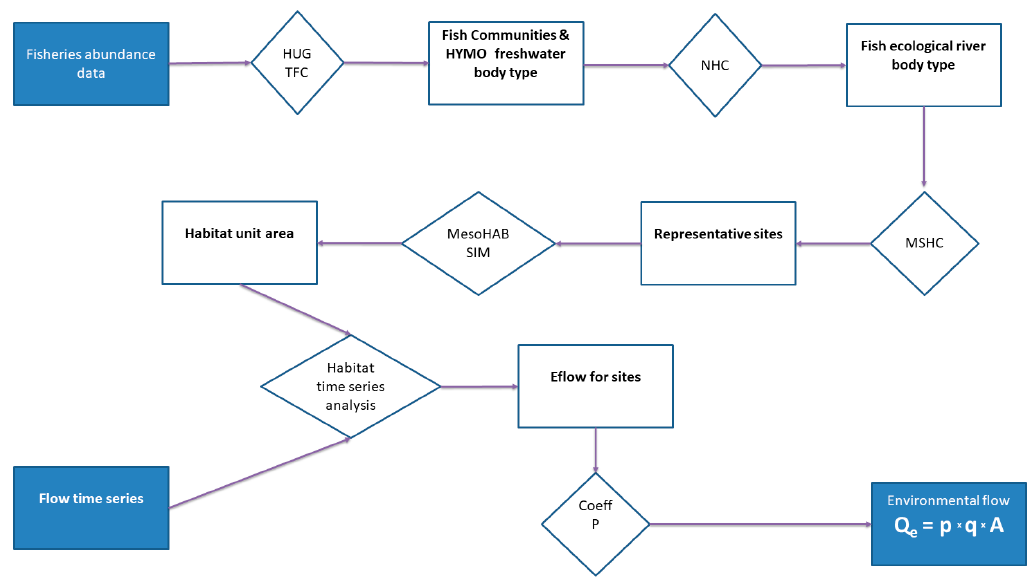
Figure 1. Scheme of eflow determination process. HUG stands for habitat-use guilds, TFC for target fish community, HYMO for hydromorphology, NHC for nonhierarchical cluster analysis, MSHF for multiscale hierarchical framework, Coeff P for coefficient p.